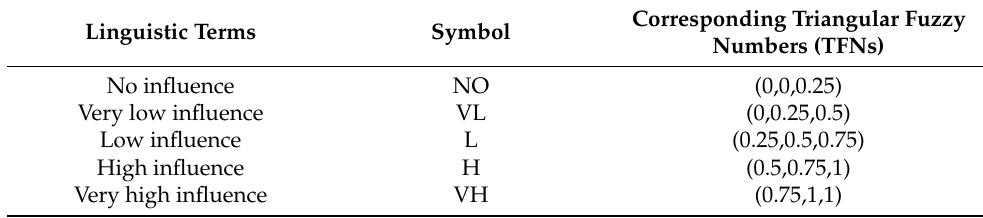
Table 2. The fuzzy scale [58–61].